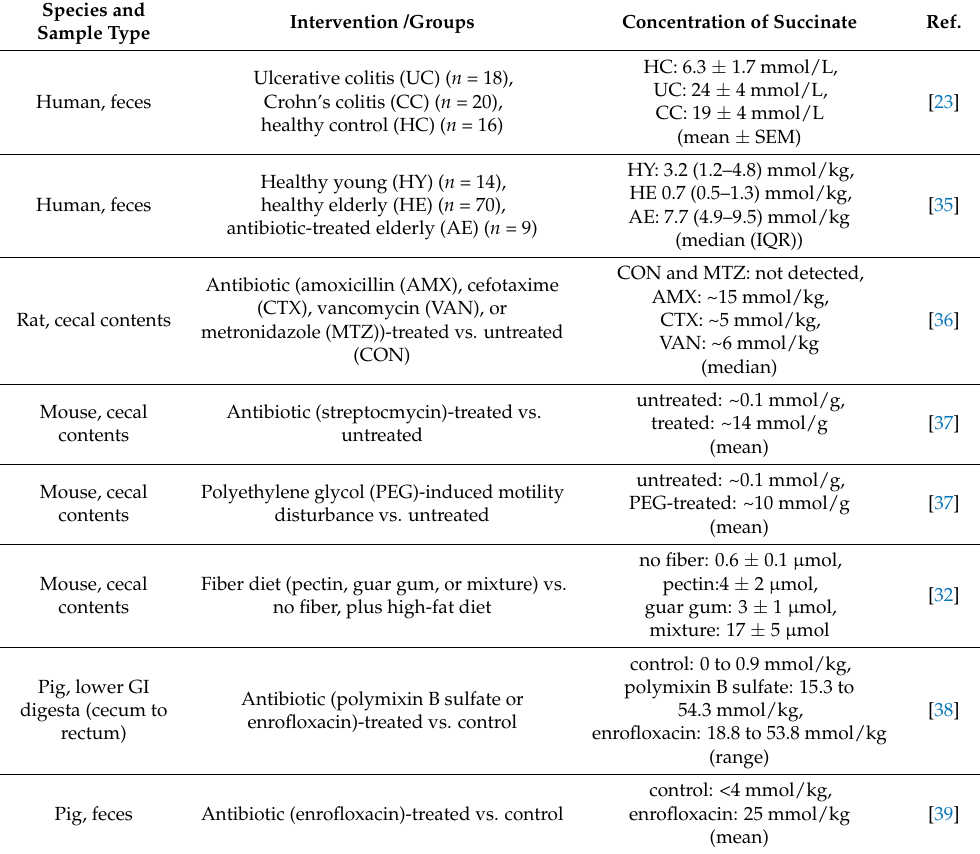
Table 1. Summary of changes in concentration of succinate in intestinal luminal contents from studies involving gut microbiota disturbances and/or intestinal